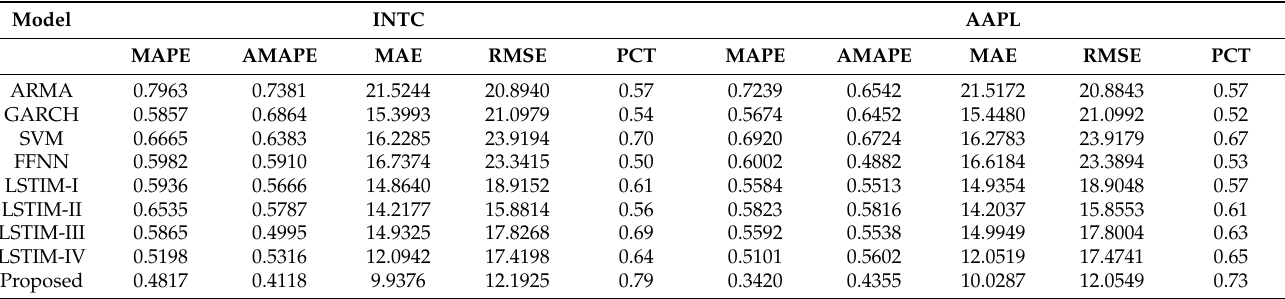
Table 15. Prediction performance for 300 days: INTC and AAPL.